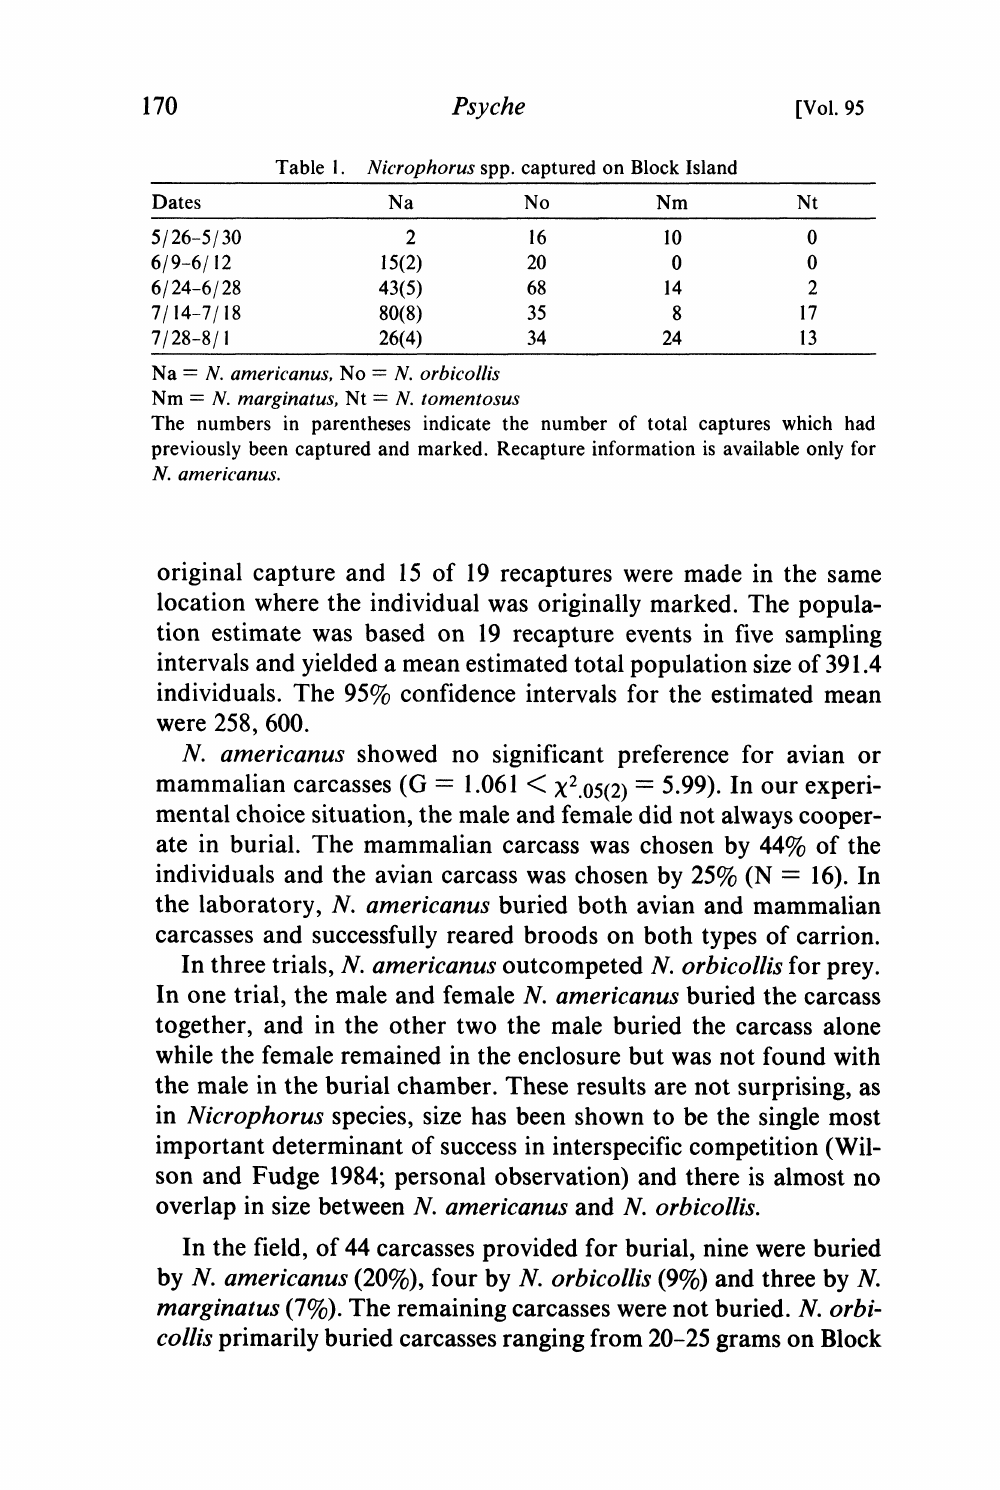
Table I. Nicrophorus spp. captured on Block